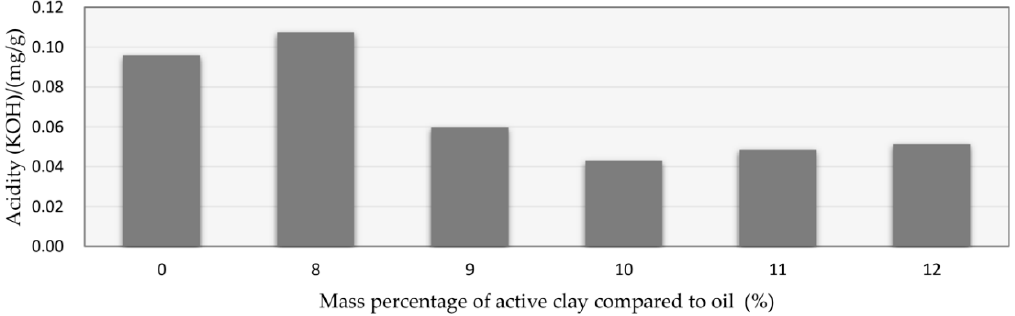
Figure 5. Effect of treatment with different amounts of active clay on the Jatropha curcas seed oil acid value. Oils had been pre-treated with KOH (1% w/w).